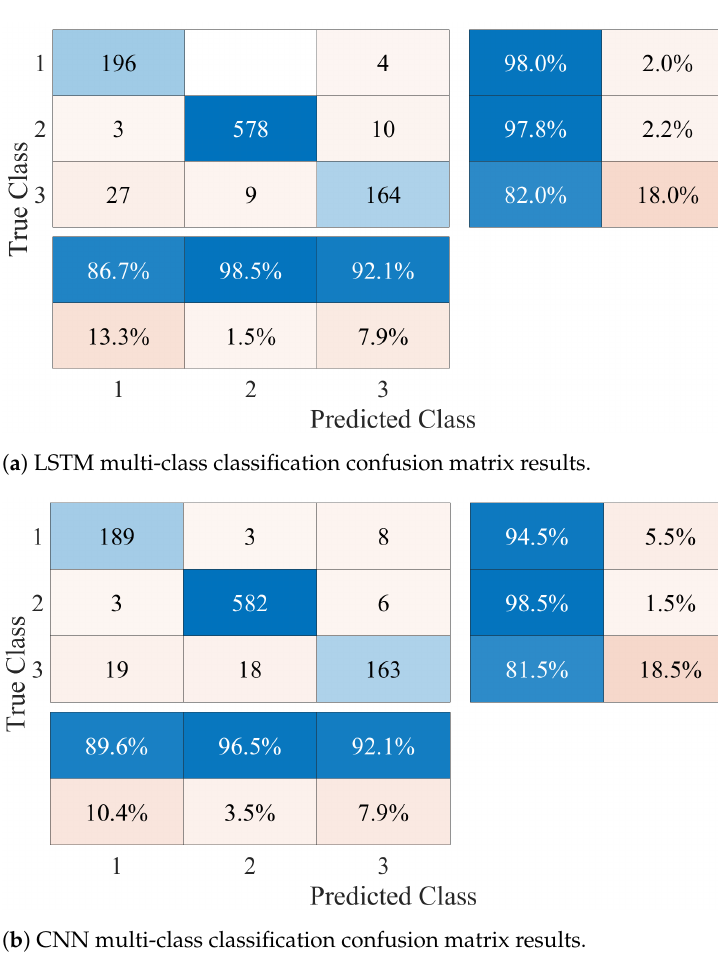
Figure 11. Confusion matrices of both classification frameworks where the classes correspond to (1) no activity, (2) walking, and (3) falling.